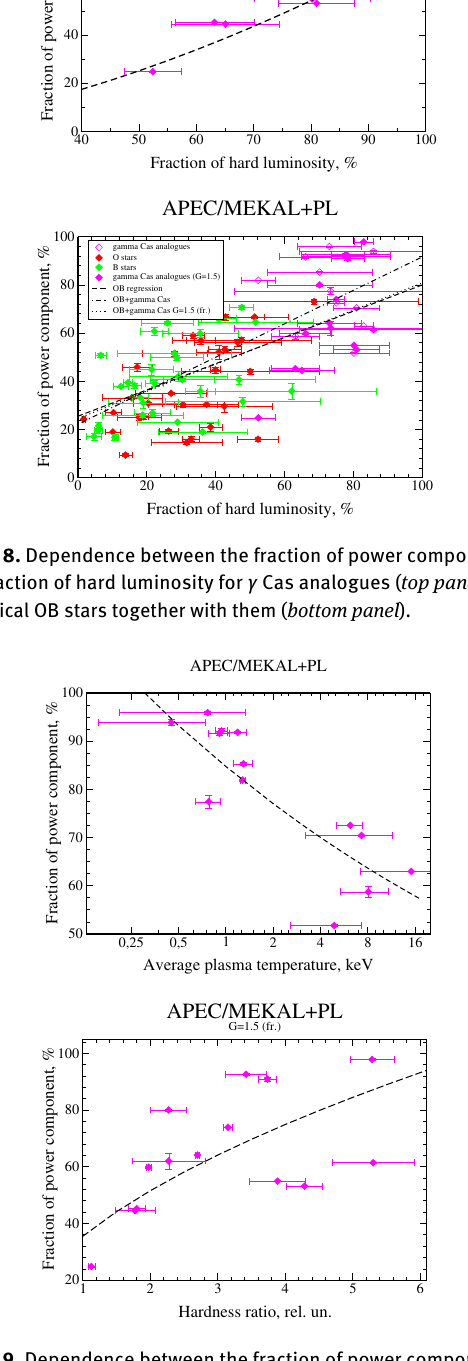
Figure 7. Dependence between the average plasma temperature and hardness ratio for γ Cas analogues ( top panel ) and for typical OB stars together with them ( bottom panel ).